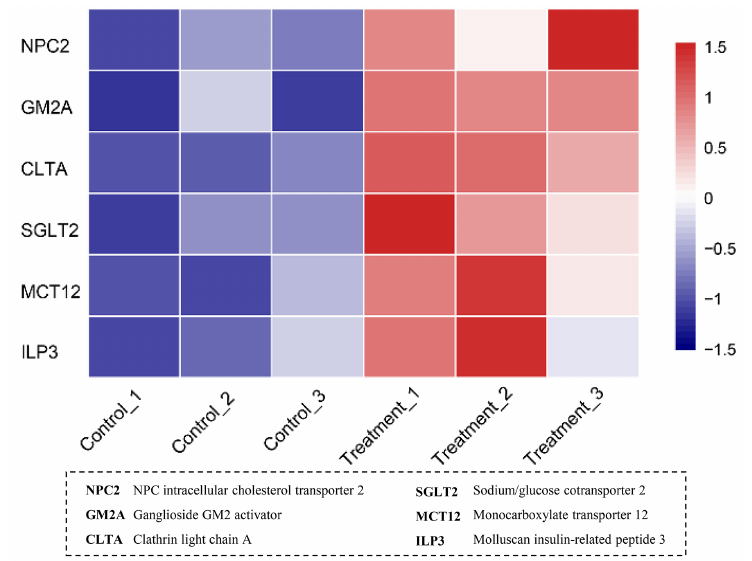
Figure 4. Heatmap showing the expression levels of the most significant differentially expressed genes after Heterosigma akashiwo exposure in the clam Meretrix meretrix . The color scale indicates the Row Z-score from the FPKM value.